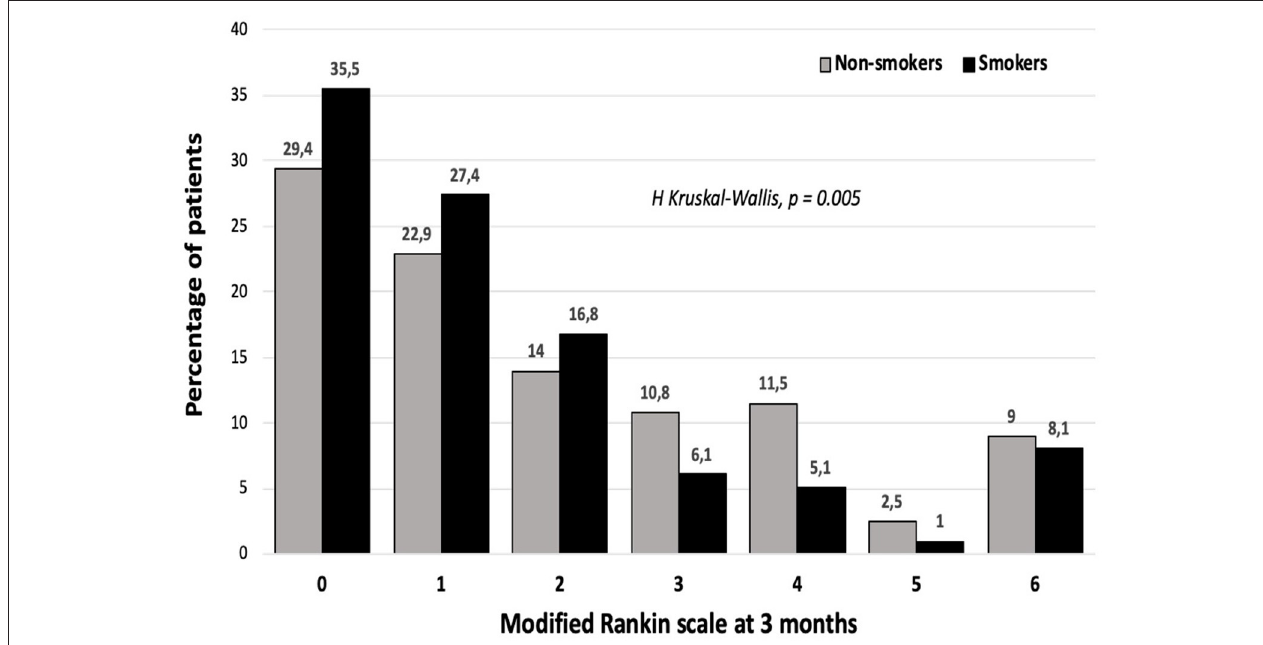
FIGURE 1 | The Ranking scale distribution among smoker and non-smoker